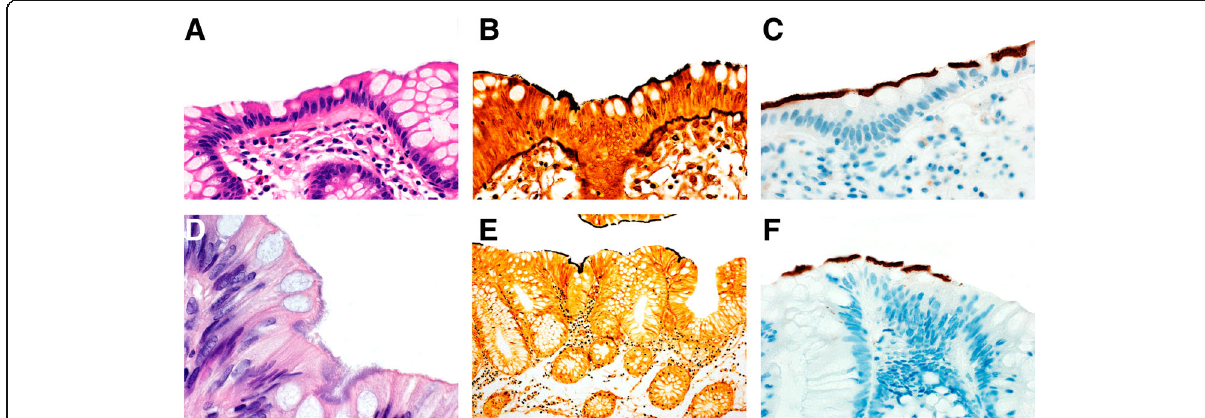
Fig. 1 a Hematoxylin and eosin stained section of colonic epithelium showing the characteristic histology of intestinal spirochetosis (Original magnification × 600). b The Warthin – Starry stain highlights the Brachyspira species along the apical aspect of the colonic epithelium (Original magnification × 600). c The T. pallidum immunostain robustly highlights the Brachyspira species without significant background staining